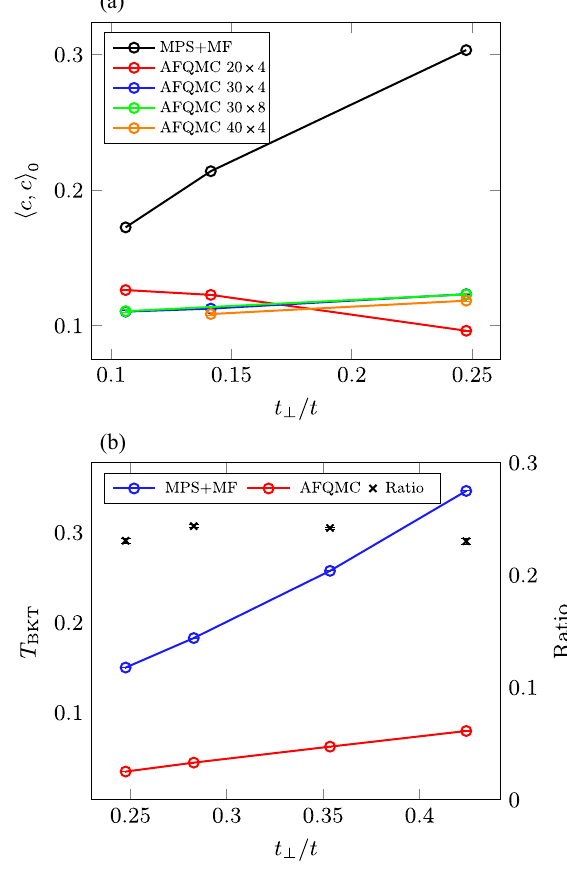
FIG. 12. Comparison of AFQMC and MPS þ MF for (a) ground-state order parameter at U ¼ − 2 t , n ¼ 0 . 5 and (b) T from MPS þ MF and T c and n ¼ 0 . 5 . Black crosses denote the ratio T